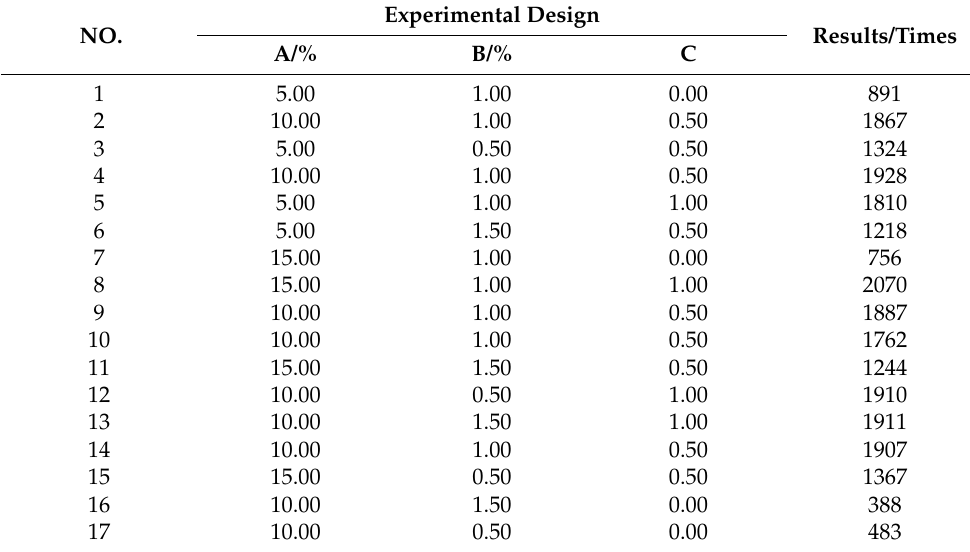
Table 9. RSM analysis design and results.